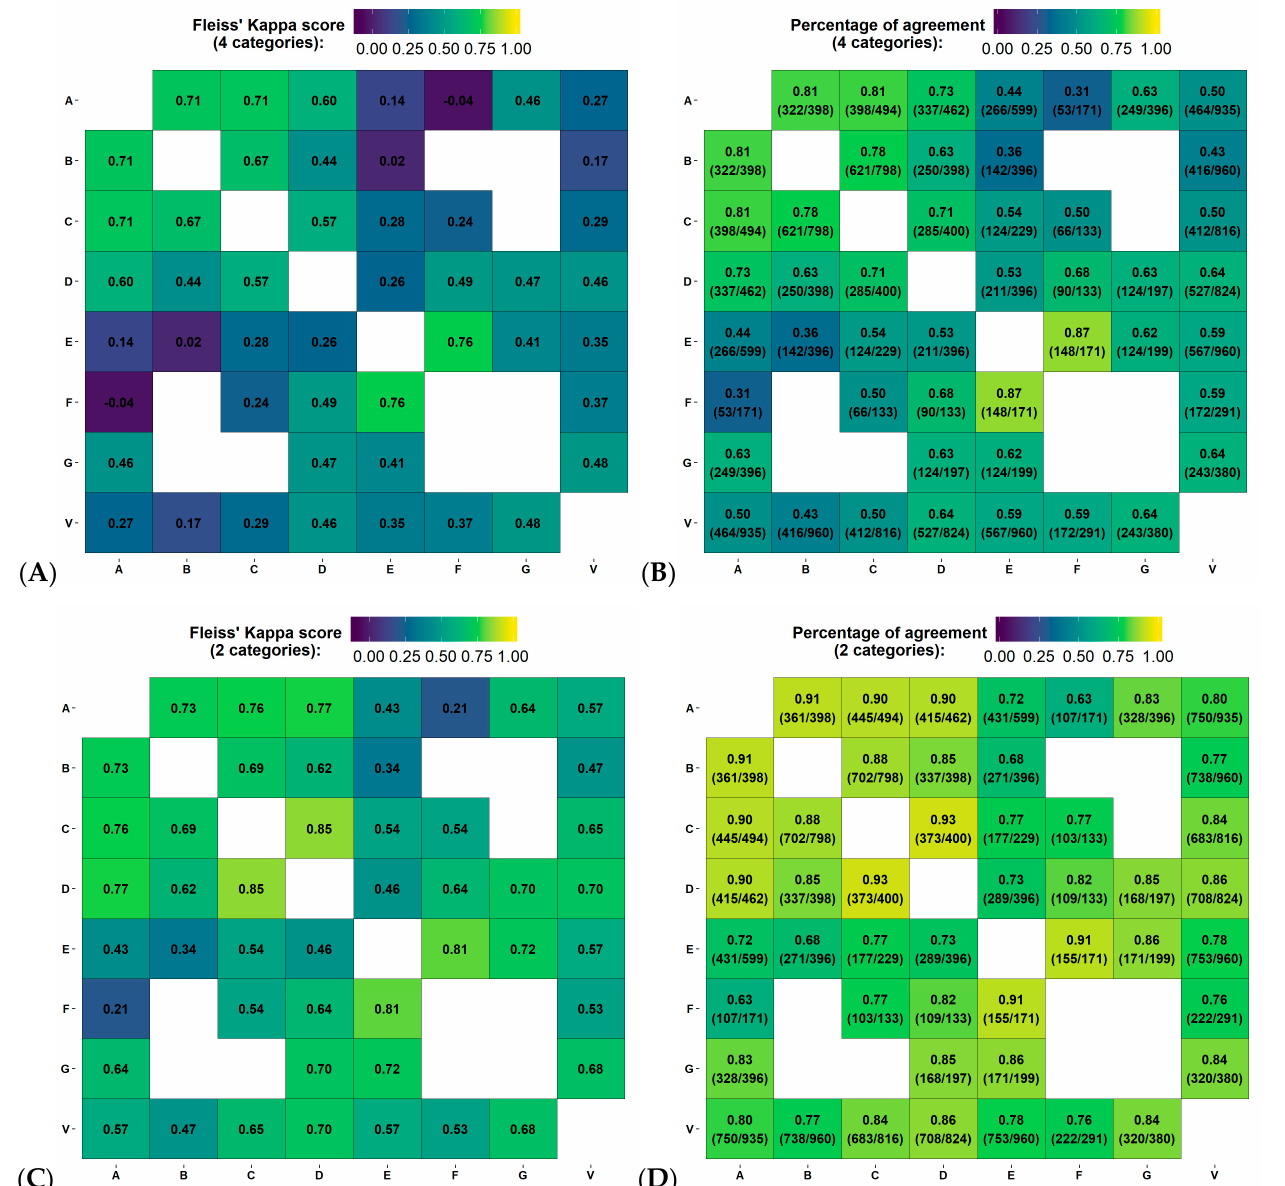
Figure 2. Variability in the estimation of breast density using Fleiss’ Kappa score and percentage of agreement between pair of observers, for all reading groups. ( A – D) represent the agreement between 4 (i.e., fatty, scattered fibroglandular densities, heterogeneously dense or extremely dense) and 2 categories (non ‐ dense or dense), on the first screening year of the test dataset. Physician experience in years of service: A = 8, B = 13, C = 8, D = 9, E = 5, F = 20 and G = 22 years. V = Volpara version 17.